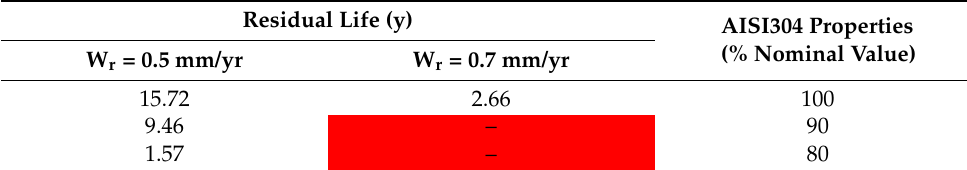
Table 3. Residual life (Lr) beyond 30 years of operation vs. 304L properties’ reduction [8].